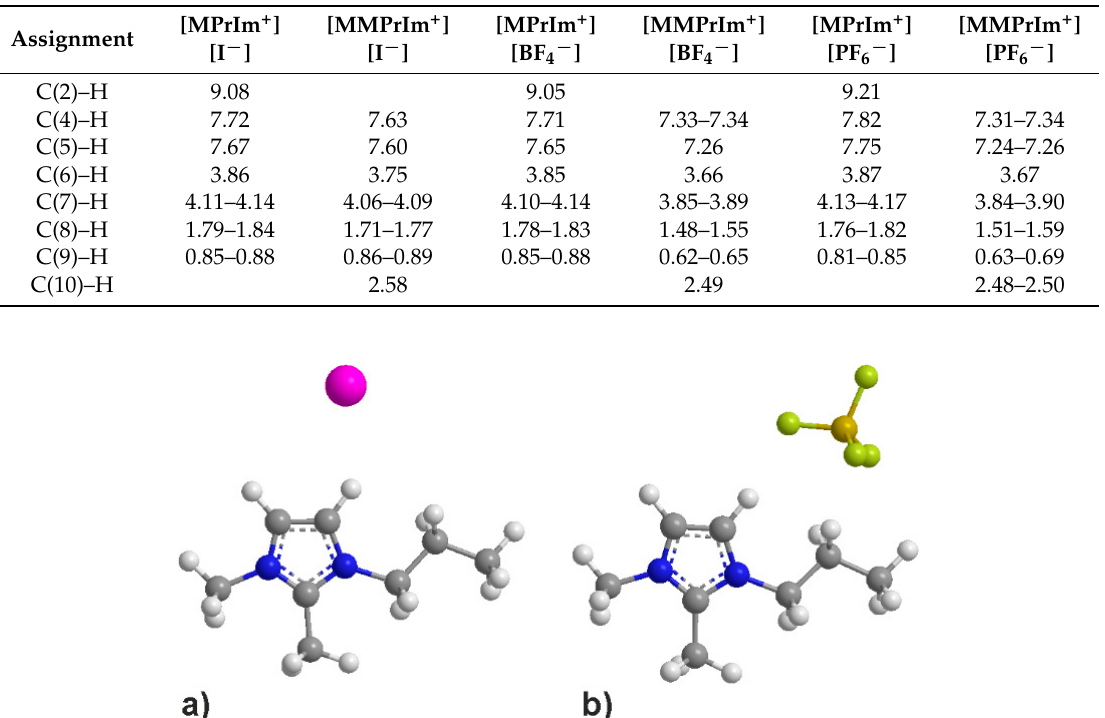
Table 3. 1 H-NMR peaks and assignments.